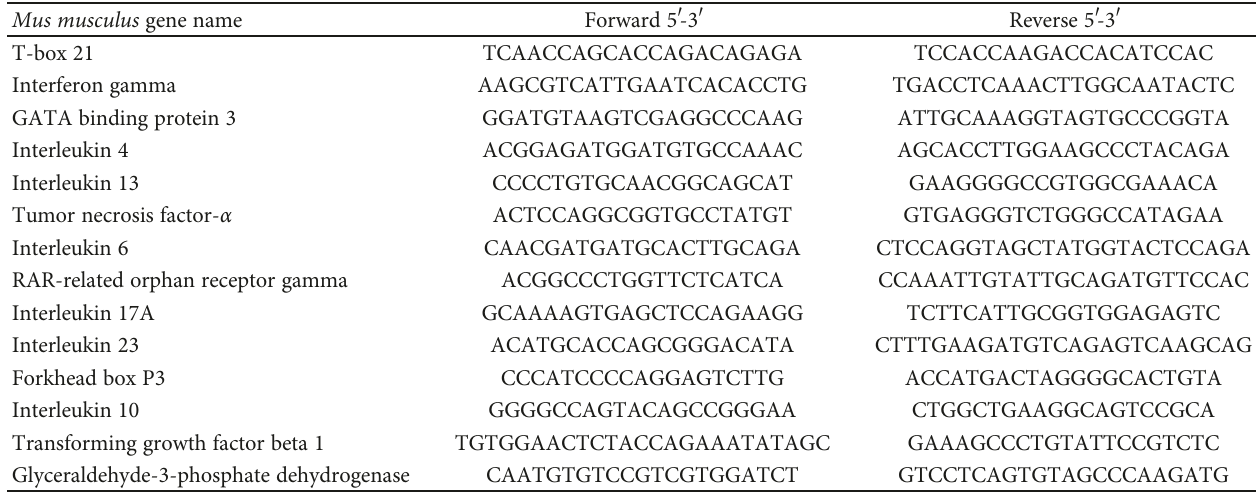
Table 1: Primer sequences for real-time